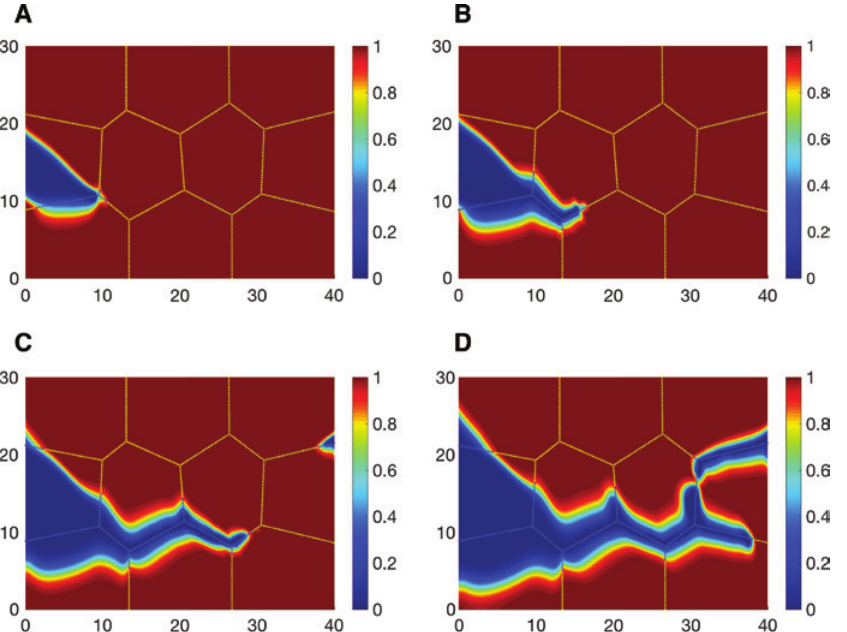
Figure 4: Crack propagation for the first situation (C1) corresponding to the low mechanical loading. The IGSCC is clearly captured.